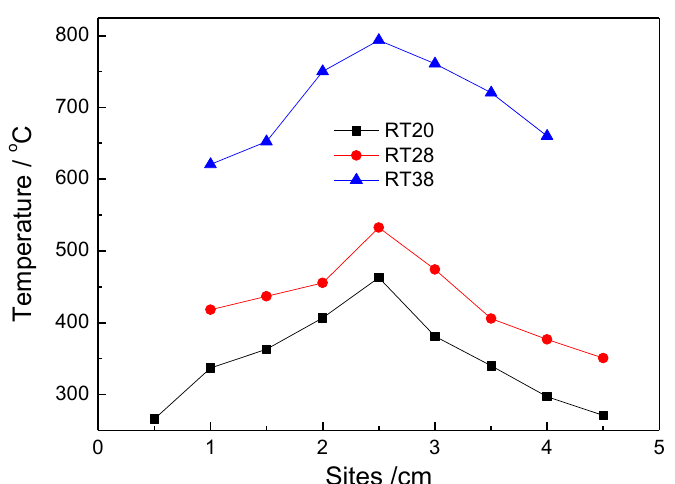
Figure 8. Temperature variation of the catalyst disc surface under different room temperatures. Conditions: 0.1 MPa CO 2 , 0.5 mL H 2 O, concentrating ratio of 800, measured at noon.